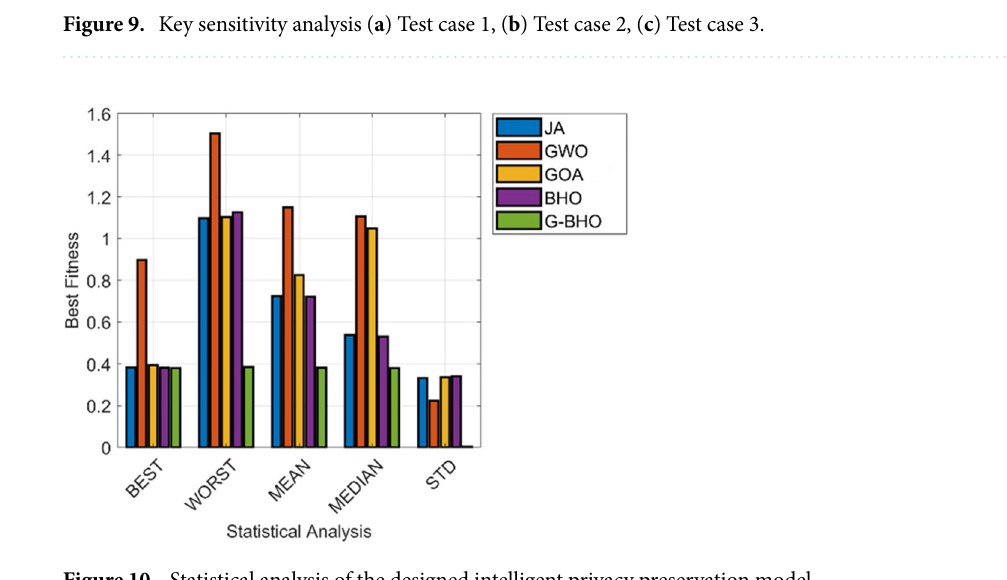
Figure 10. Statistical analysis of the designed intelligent privacy preservation